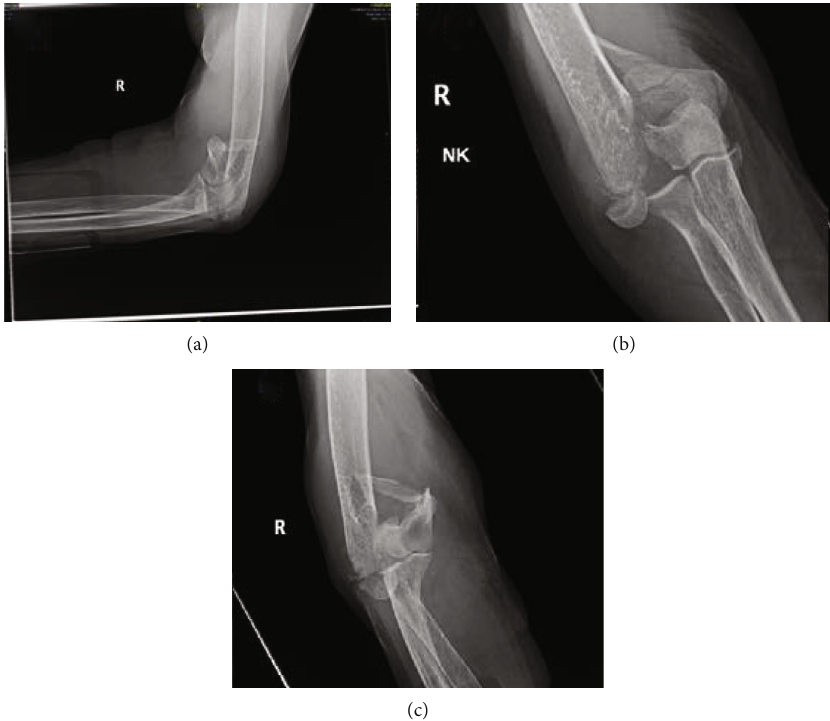
Figure 2: Plain radiograph of the right elbow with (a) the lateral view showing a comminuted distal humeral fracture, (b) AP view showing a bicondylar distal humeral displaced fracture, and (c) showing the right elbow with a two column distal humerus fractures classi fi ed as lateral lambda as per the Jupiter classi fi cation.